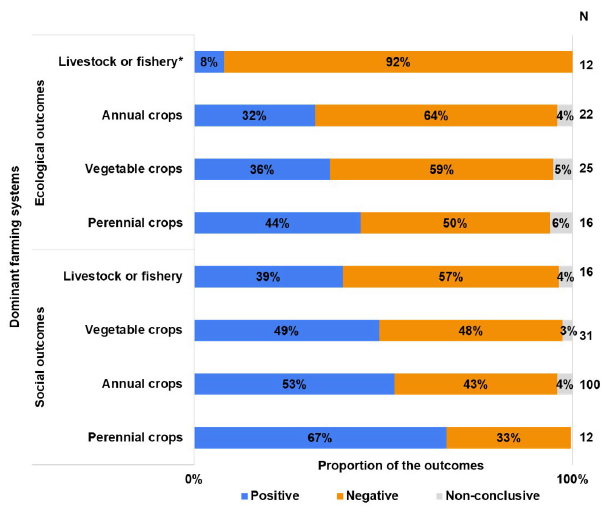
Fig. 7 . Ecological and social outcomes of urbanization on regional farming systems across dominant farming systems (* Outcomes are statistically significant at p < or =